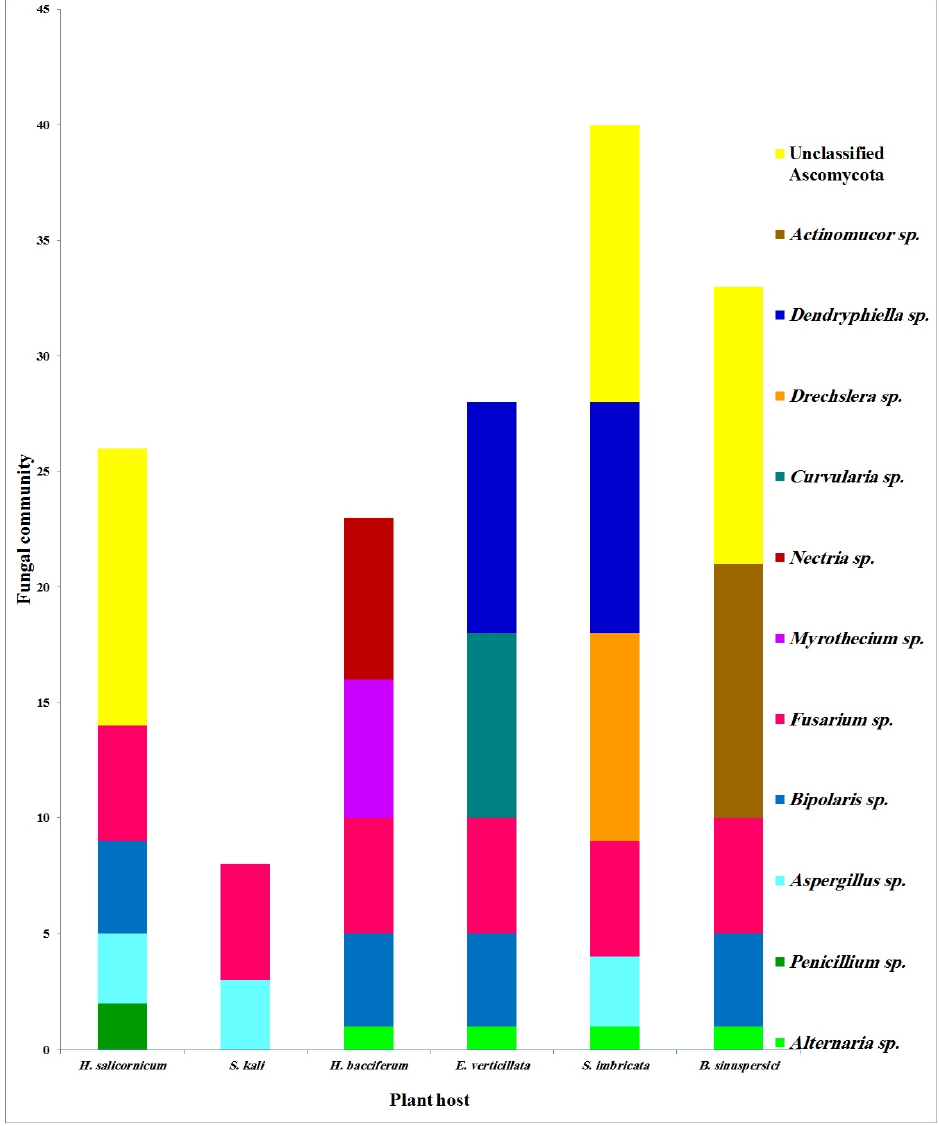
Figure 4. Stacked bar chart showing the common endophytic fungal genera isolated from the six wild stress-tolerant plant hosts.